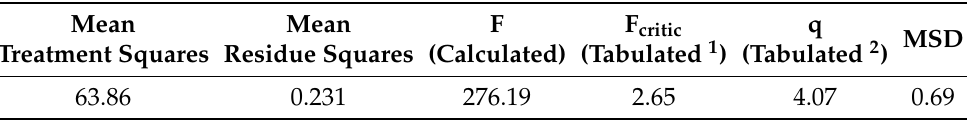
Table 6. ANOVA and Tukey’s test statistical parameters for composites’ flexural modulus.